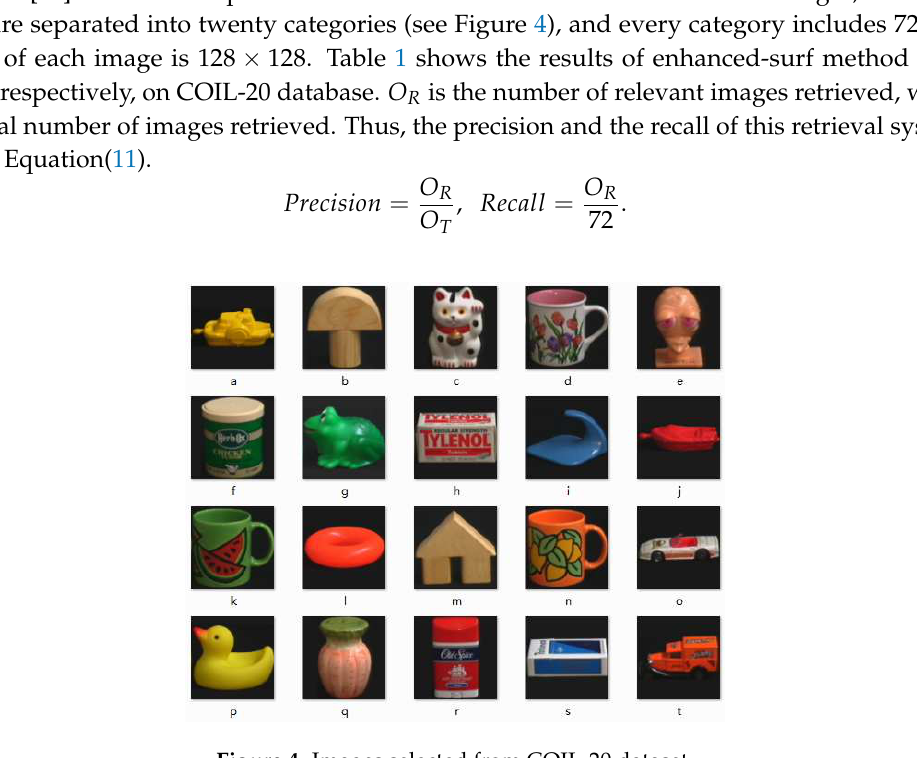
Figure 4. Images selected from COIL-20